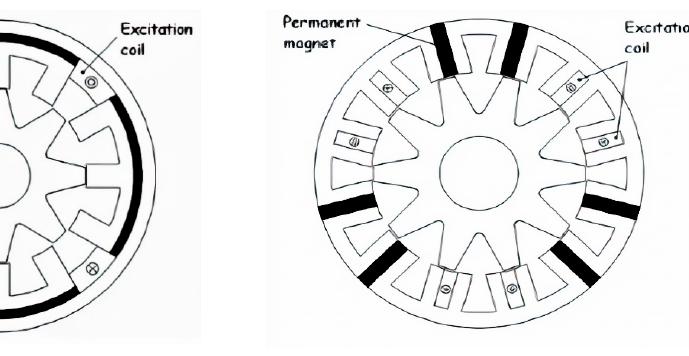
Figure 1. Main types of hybrid excited salient permanent-magnet synchronous motor (HEPMSM).